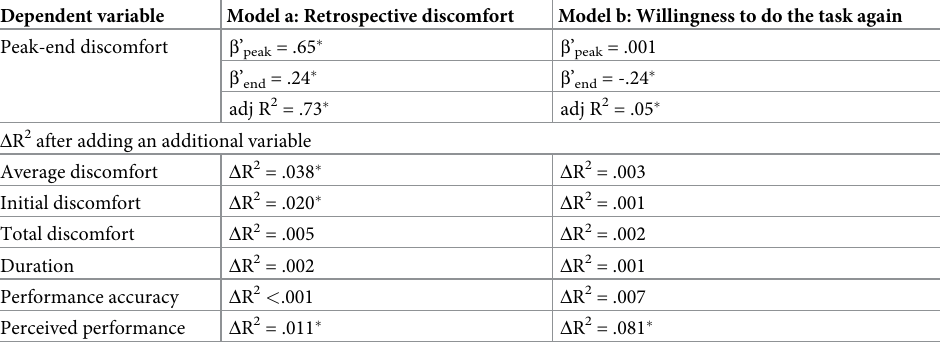
Table 4. Hierarchical regression analysis predicting retrospective discomfort and the willingness to do the task again from real-time ratings of discomfort. Dependent